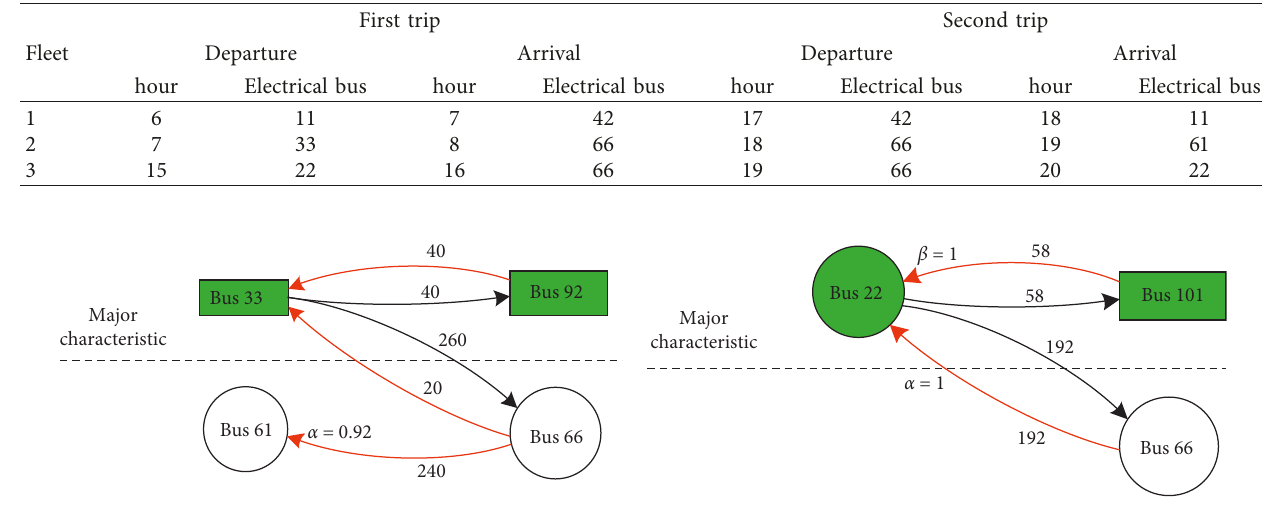
Table 7: Travel characteristics in case 3.